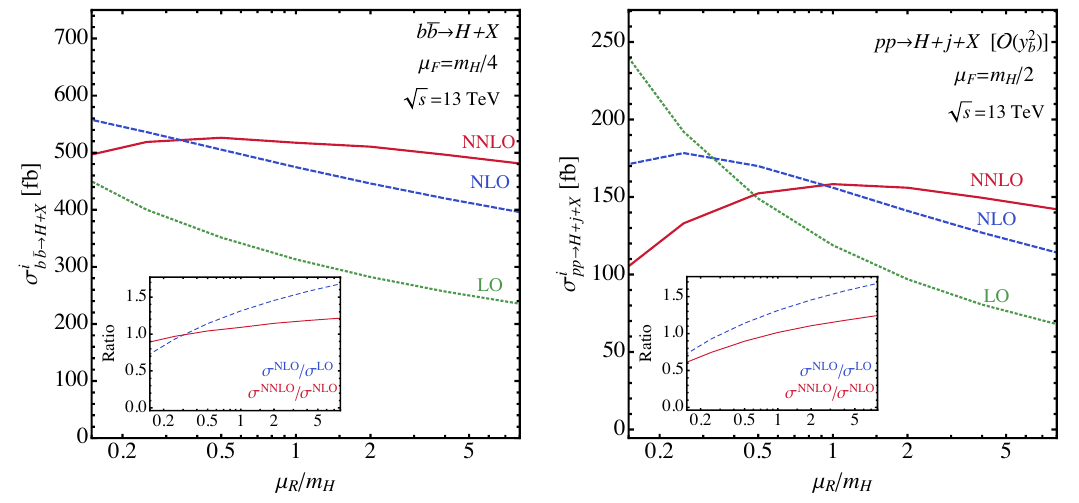
Figure 7 . Main figures: dependence of the LO, NLO, and NNLO cross sections on the renormal- ization scale (left: H + 0 j , right: H + 1 j ). Insets: ratio of the NNLO prediction to the NLO (red) and ratio of the NLO prediction to LO (blue,